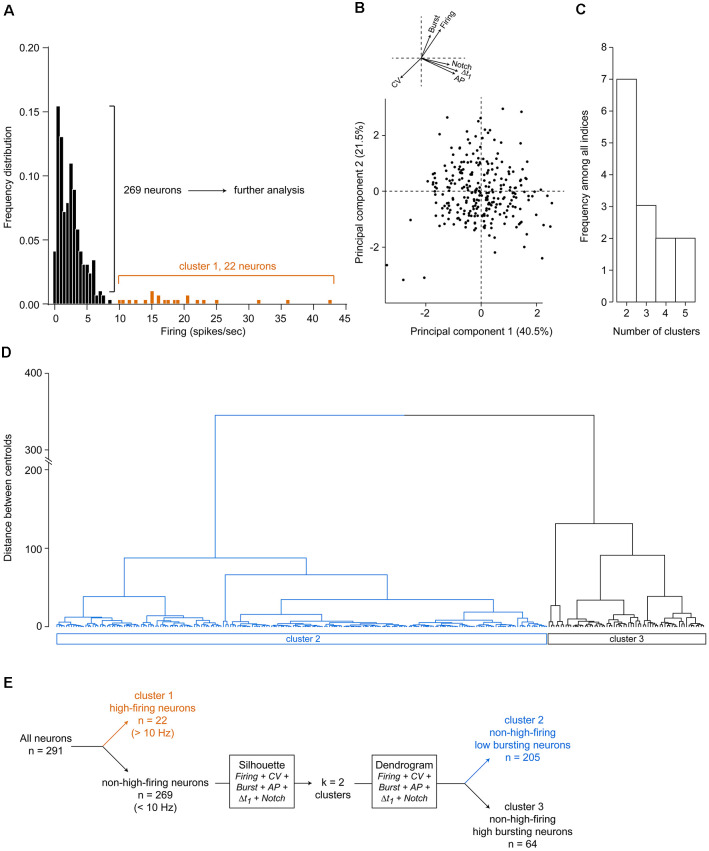
Unsupervised clustering of the 269 non-high-firing neurons. (A) Initial segregation of neurons with firing rates above 10 Hz. (B) Principal component analysis (PCA) using all six electrophysiological variables revealed that the first two principal components accounted for 62% of the total variance within the dataset. Arrows indicate vectors of the six variables. For clarity, these arrows and their respective variables are drawn again at the top left. (C) Silhouette analysis determined that the optimal number of clusters within our dataset is 2. (D) Unsupervised agglomerative hierarchical clustering with two clusters, using Euclidean distances and Ward’s method for optimal branching. (E) Methodology flow chart used in the present study.